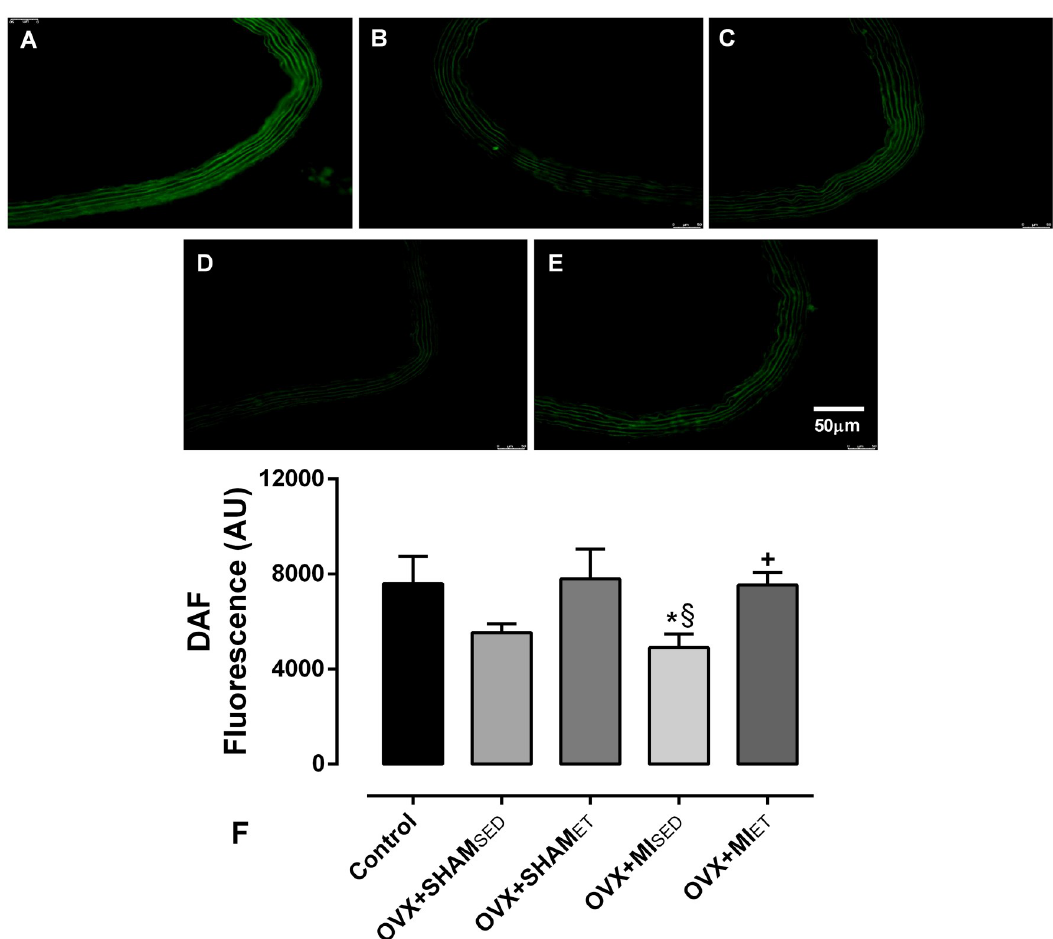
Fig 6. Evaluation of nitric oxide production "in situ" by micrographs depicting the fluorescence emitted by 4,5-diaminofluorescein diacetate in segments of the aorta vessels. Data are expressed as mean ± standard error of the mean (SEM). One-way ANOVA followed by the Fisher post-hoc test for multiple comparisons. � p < 0.05 vs Control; § p < 0.05 vs OVX+SHAM ET ; + p < 0.05 vs OVX+MI SED